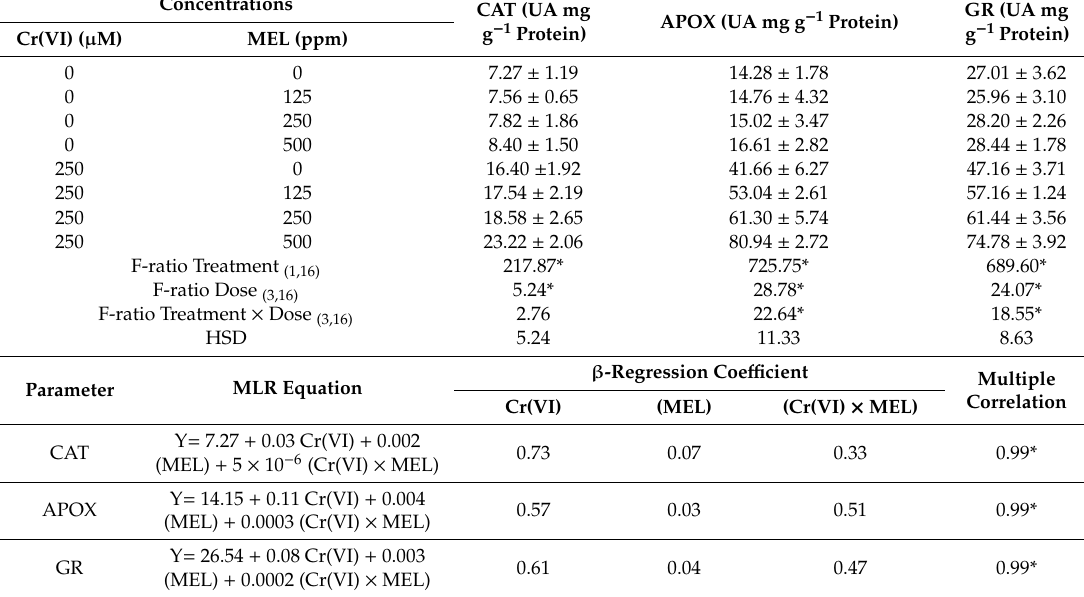
Table 4. E ff ect of Cr(VI), di ff erent concentrations of methanol extract of Rhododendron arboreum leaves (MEL), and their combinations on the activities of catalase (CAT), ascorbate peroxidase (APOX), and glutathione reductase (GR) enzymes in 7-day-old Vigna radiata seedlings. The values are the means of three replicates ± SD. (standard deviation). Tukeys test performed and significance checked at * p ≤ 0.05. The F ratio is the term in which ANOVA is represented; Cr(VI) = Dose, MEL treatments = Treatment and combination of Cr(VI) and MEL = Dose × treatment. Concentrations CAT (UA mg g − 1